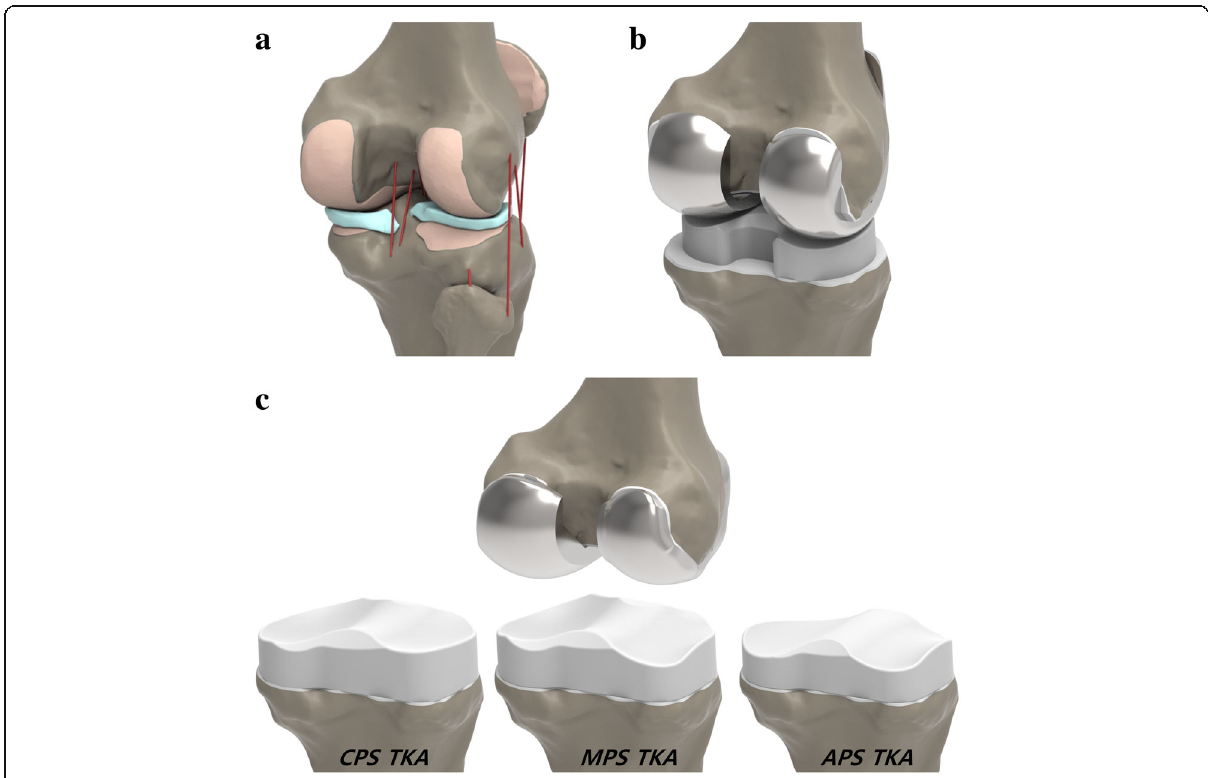
Fig. 3 FE model for a normal knee, b conventional TKA and c three different conformity of patient-specific TKA used in this